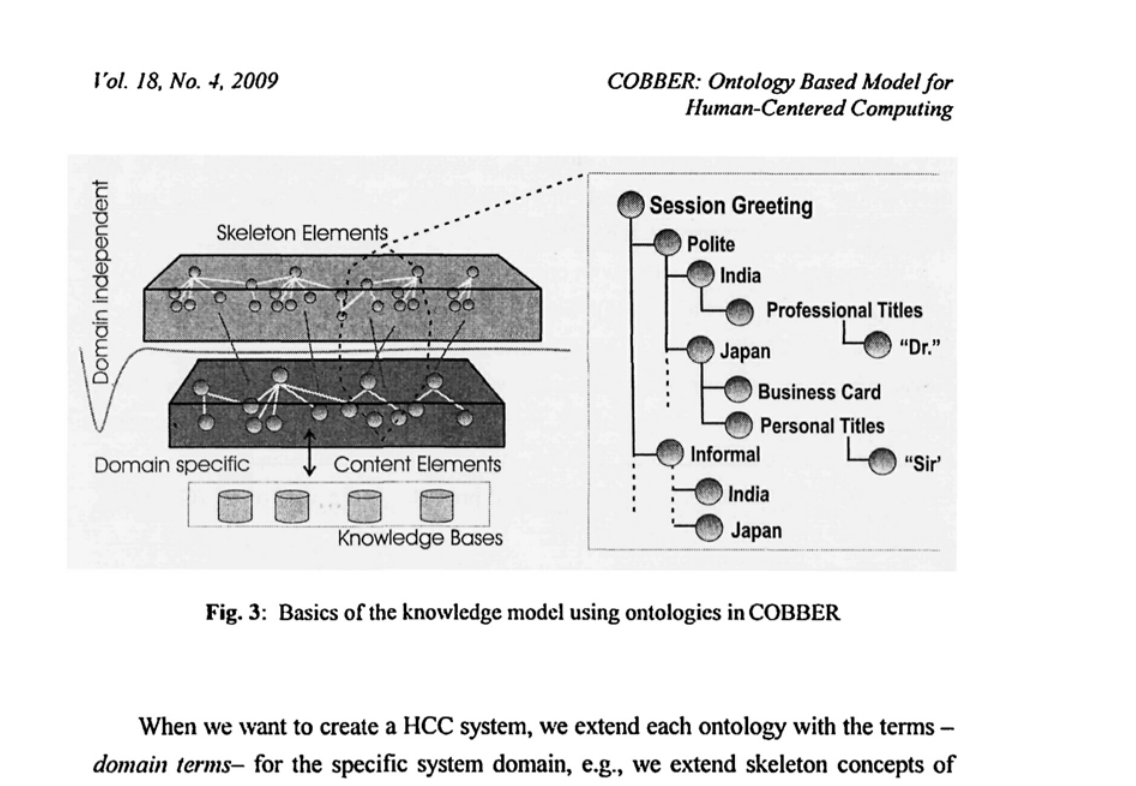
Fig. 3: Basics of the knowledge model using ontologies in